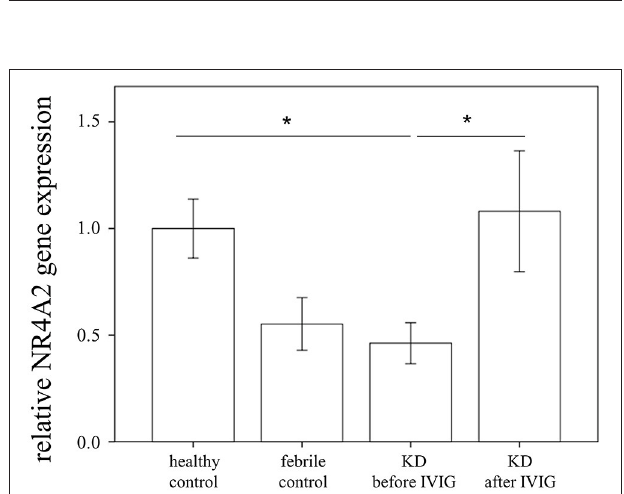
FIGURE 3 | Analyses of NR4A2 mRNA in the peripheral white blood cells of 48 patients with KD before and after intravenous immunoglobin administration, as well as 48 healthy and 24 febrile controls using qRT-PCR. Data are expressed as mean ± standard error. *Significance ( p < 0.05) between the